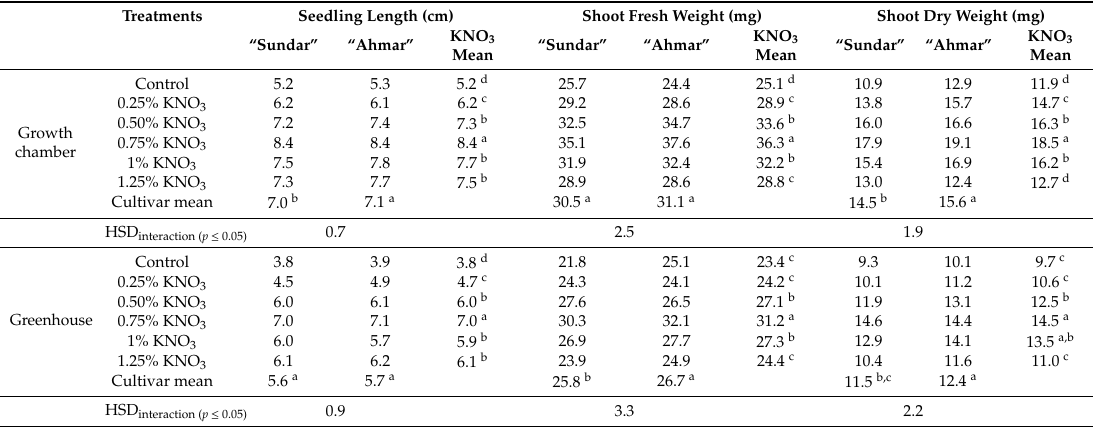
Table 2. Seedling length, shoot fresh weight, and shoot dry weight of tomato as a ff ected by seed priming with KNO 3 under two di ff erent growth conditions. Treatments Seedling Length (cm) Shoot Fresh Weight